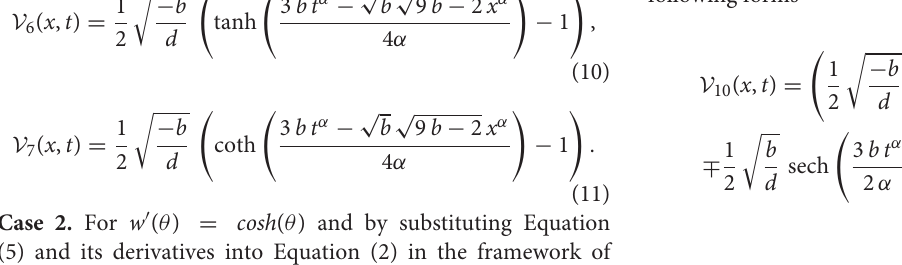
Frontiers in Physics |